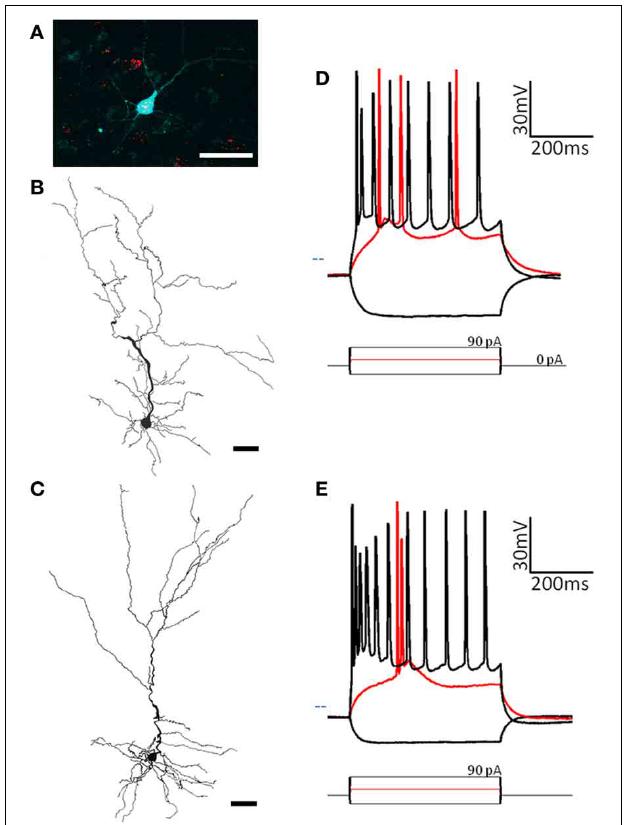
FIGURE 2 | Two subtypes of pyramidal cells are found in pars principalis. (A) Cells containing red microbeads from a tracer injection into the olfactory bulb, and the pyramidal cell targeted for recording and filled with biocytin (blue). Scale bar = 50 µ m. (B,C) Cameralucida drawings of a typical superficial pyramidal cell (B) and a typical deep pyramidal cell (C) show similar morphologies. Scale bar = 100 µ m. (D,E) Voltage responses (top) for three current steps (bottom) in a typical superficial pyramidal (D) and a deep pyramidal cell (E) . Red traces are at rheobase. Dotted line indicates transmembrane voltage of −